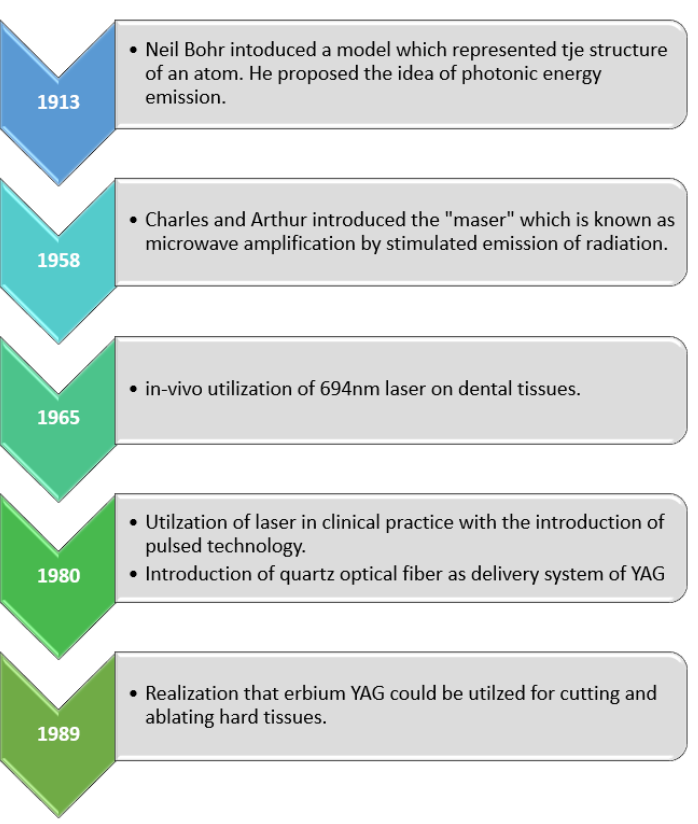
Figure 3. Timeline of lasers.